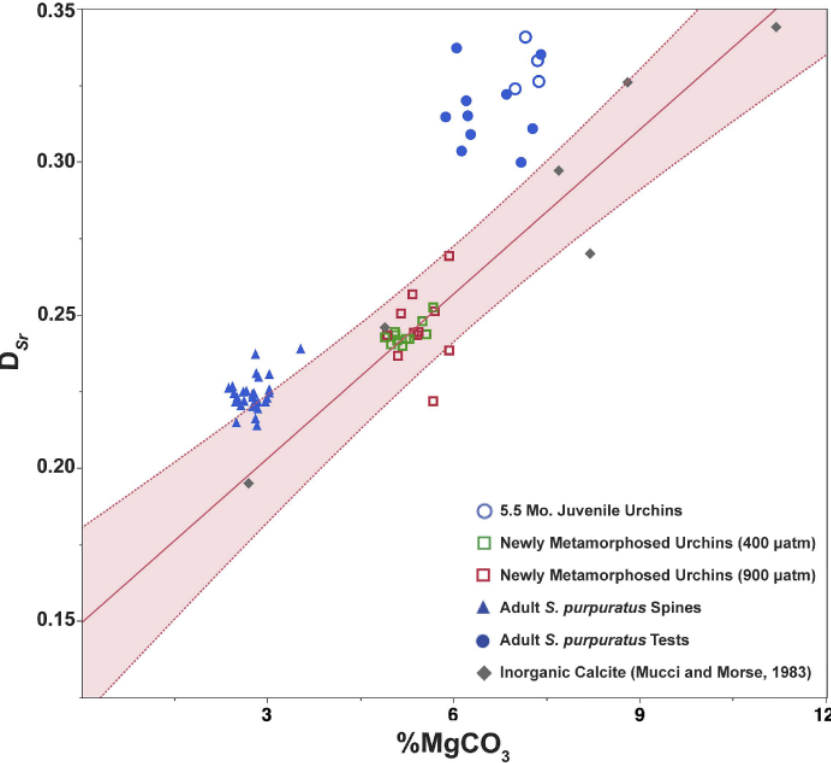
Fig. 2. The relationship between skeletal magnesium content (expressed as %MgCO 3 ; x-axis) and strontium partition coefficient ( D Sr ; y- axis) for S. purpuratus adult spines (blue filled triangles), adult tests (blue filled circles), 5.5-month-old cultured juvenile tests (open blue circles), and newly metamorphosed juveniles settled after 48–49days in culture at 400 (green open squares) and 900 (red open squares) µatm p CO 2 . Linear regression and 95% confidence intervals plotted in red shading derived from inorganic calcite precipitation experiments (grey filled diamonds; Mucci and Morse